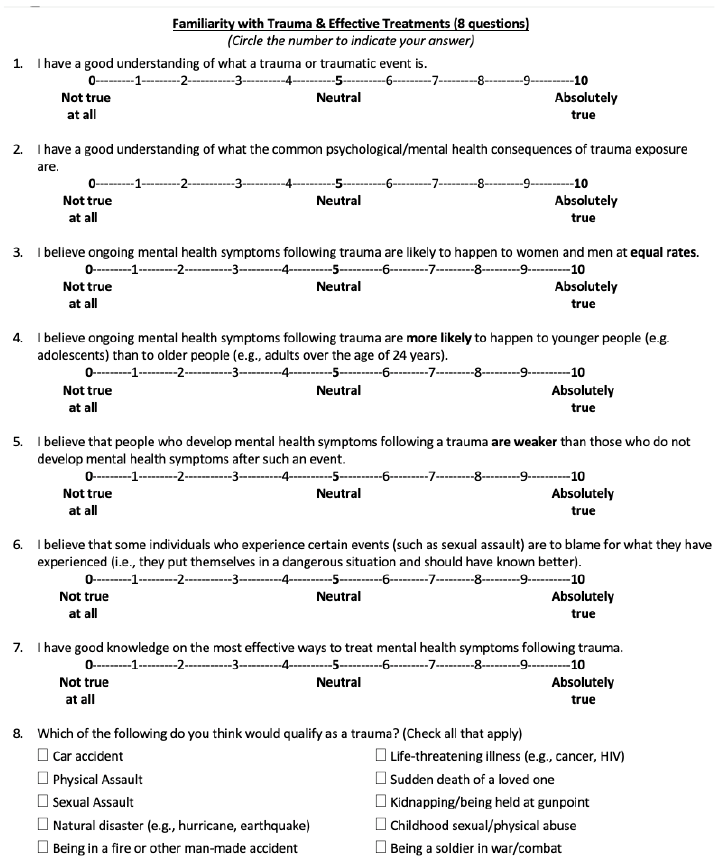
/ stigma about trauma and e ff ective treatments questionnaire Figure 1. Knowledge/stigma about trauma and effective treatments questionnaire items. Figure 1. Knowledge